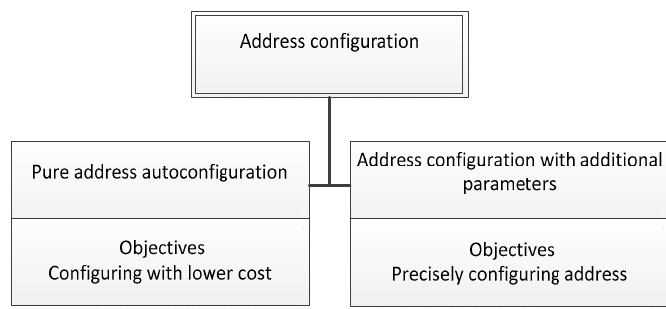
Figure 2. The taxonomy of the addressing configuration problems.